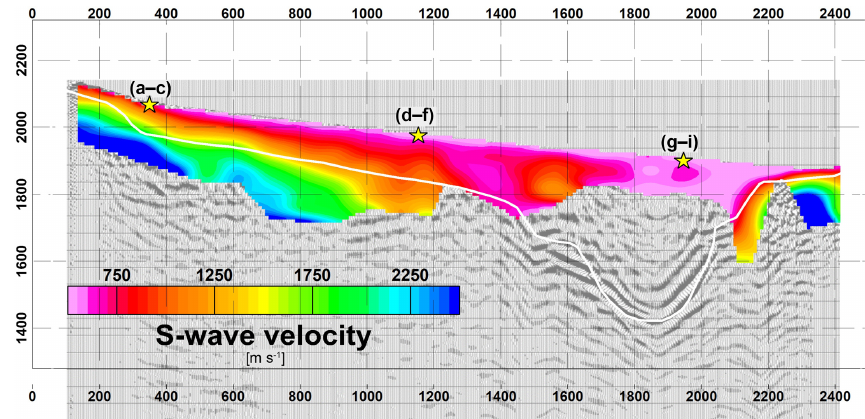
Figure 8. S-wave velocity model obtained from interpolation of local 1-D shear wave velocity profiles. Stars: location of the corresponding 1- D inversions shown in Fig. 7. White line: interpreted top of the consolidated Precambrian basement based on P-wave refraction and reflection